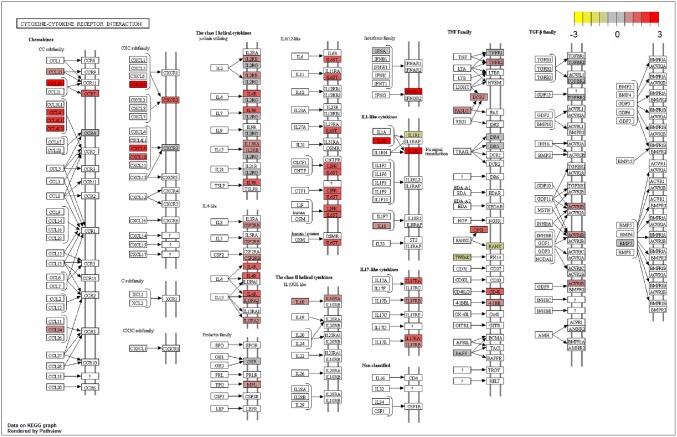
KEGG pathway map.Cytokine-cytokine receptor interaction network map for DEGs of vaccinated fish. Red squares represent upregulated genes, while yellow shows downregulated genes. Grey are genes with lower expression levels. Fold change values are represented in log2 scale.